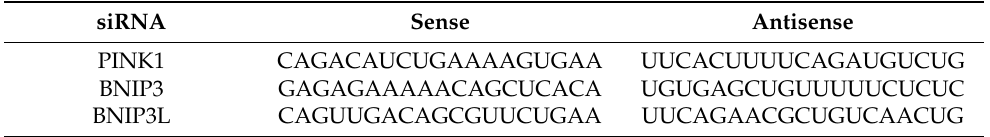
Table 2. siRNA sequences used in this